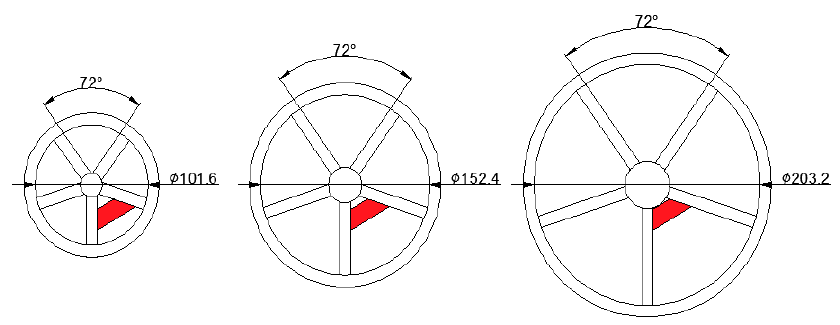
Figure 3. Trapezoidal block.